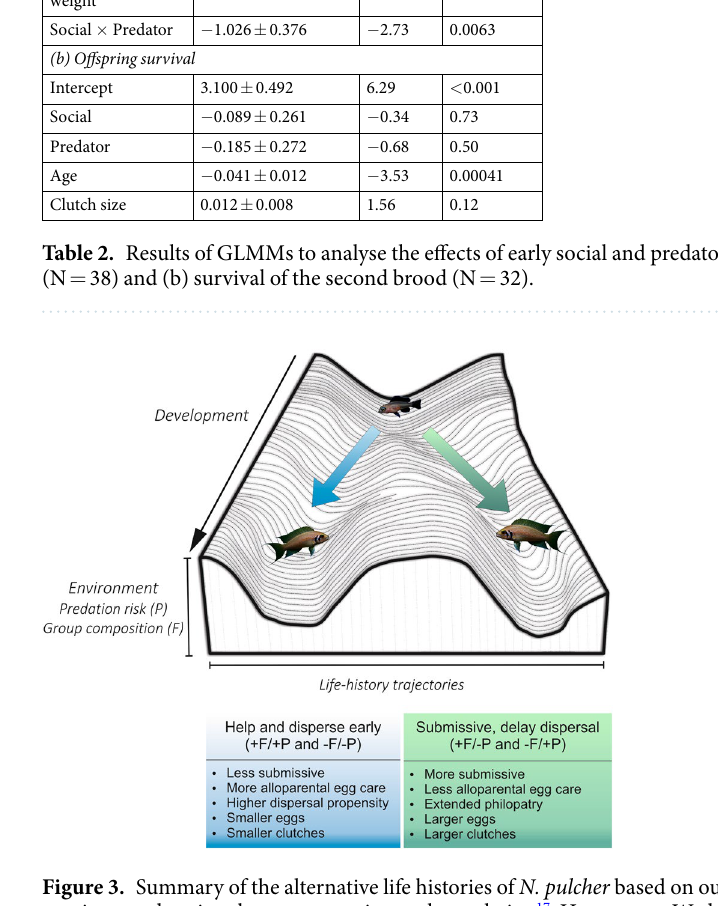
Figure 3. Summary of the alternative life histories of N. pulcher based on our experimental results and a previous study using the same experimental population 17 . Here we use Waddington’s landscape metaphor to illustrate how we envisage that starting from a generalist phenotype a specialization into two alternative life history strategies occurs over the developmental time of N. pulcher . At the beginning of their development (i.e at the top end of the valley), young N. pulcher start life without specialization. The downward slopes of the valleys represents developmental time. The environment in which a young N. pulcher is born biases its development to pursue the blue (left valley) or green (right valley) strategy leading to increased specialization with the final outcome of two alternative life-history trajectories. Figure adapted from Waddington’s (1940) landscape 39